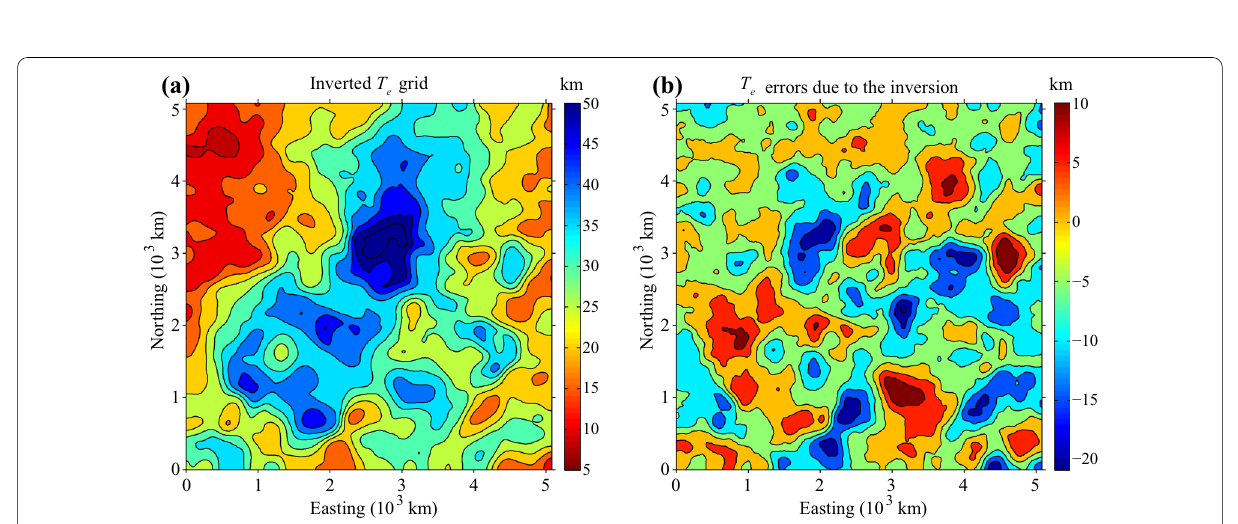
Fig. 8 a Inverted T er grid. b T er errors due to the